Question: What caption would you write for this figure?
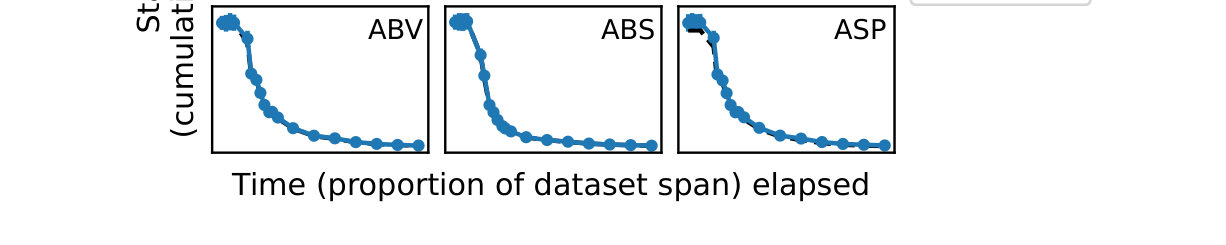
Answer: 3: The ratio between the one-way bootstrap standard error (SE) estimates [19] and the vanilla sample SE estimates for (Left) ABV, (Middle) ABS, and (Right) ASP. The error bars represent the 95% confidence interval for the one-way bootstrap SE estimates.